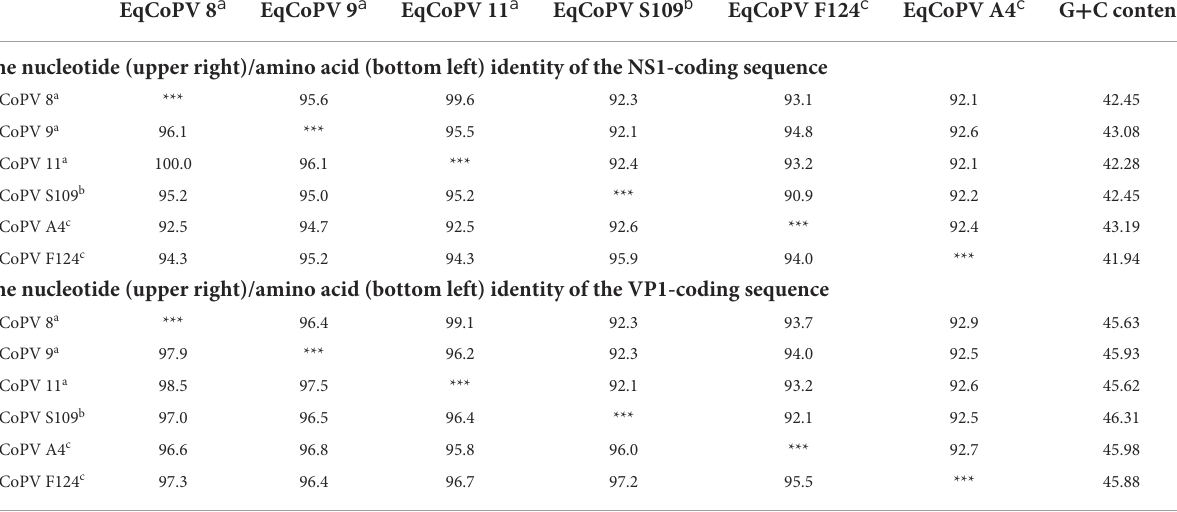
TABLE 5 Analysis of the nucleotide (upper right)/amino acid (bottom left) identity of the NS1 and VP1-coding sequences among EqCoPV strains.